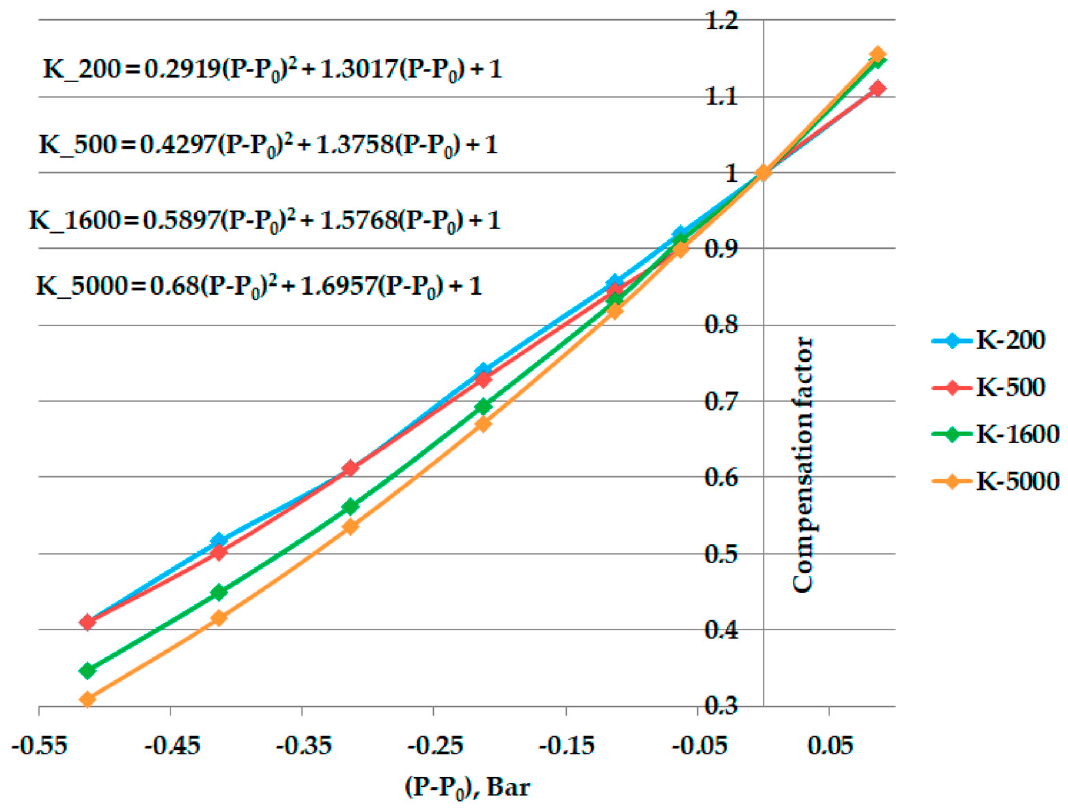
Figure 8. Compensation factor calibration dependences as a polynomial functions.